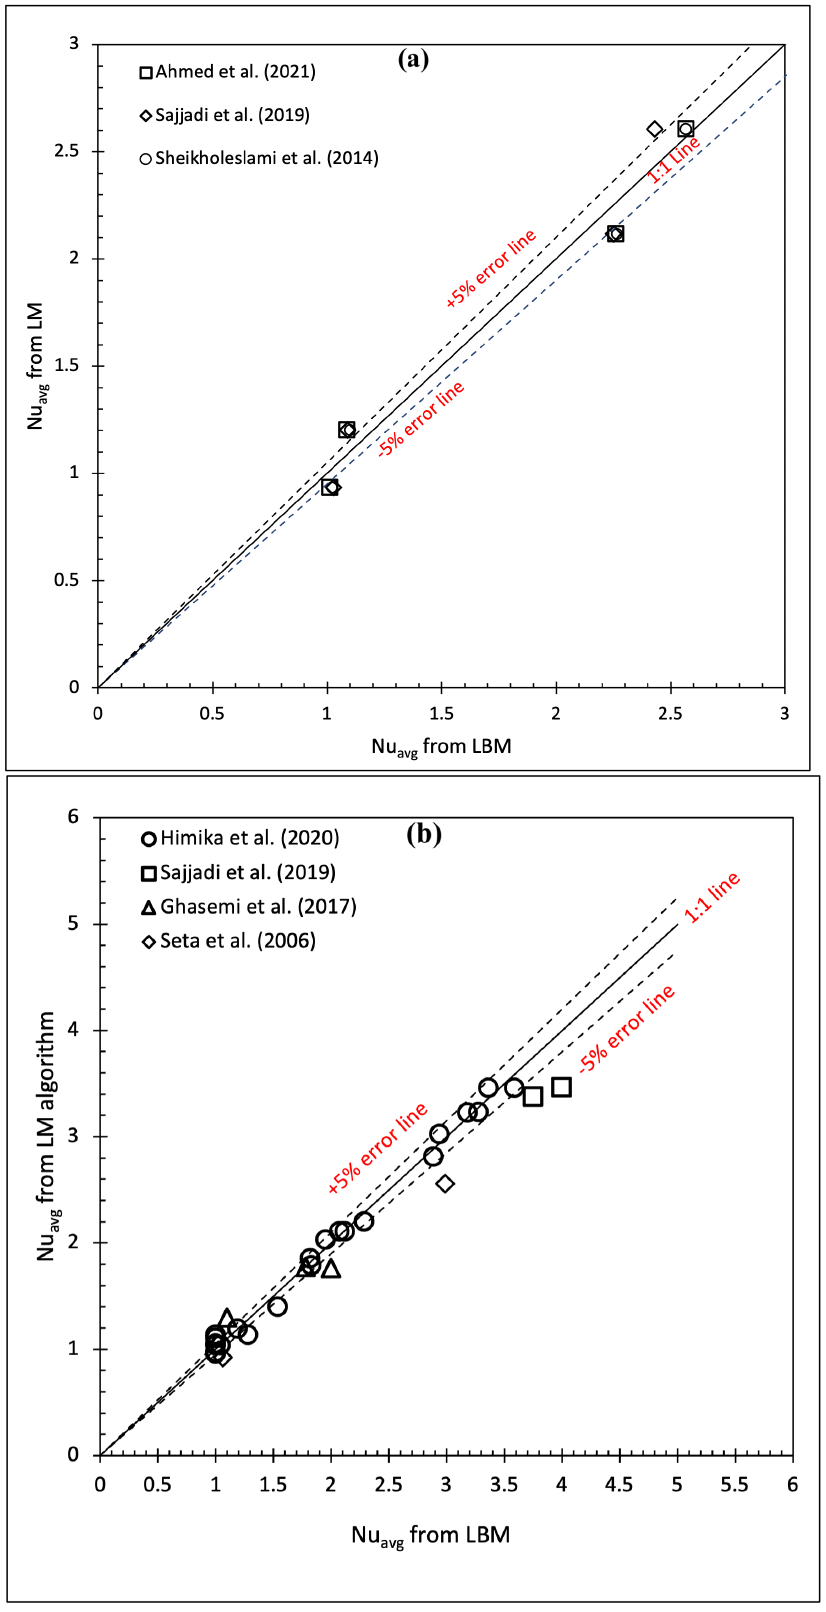
Figure 6. Cross validations with LBM data from the literature ( a ) Ra = 10 4 [16,61,62], and ( b ) Ra = 10 5 [18,62–64] under the influence of external magnetic field at different inclination angles for electrically conducting